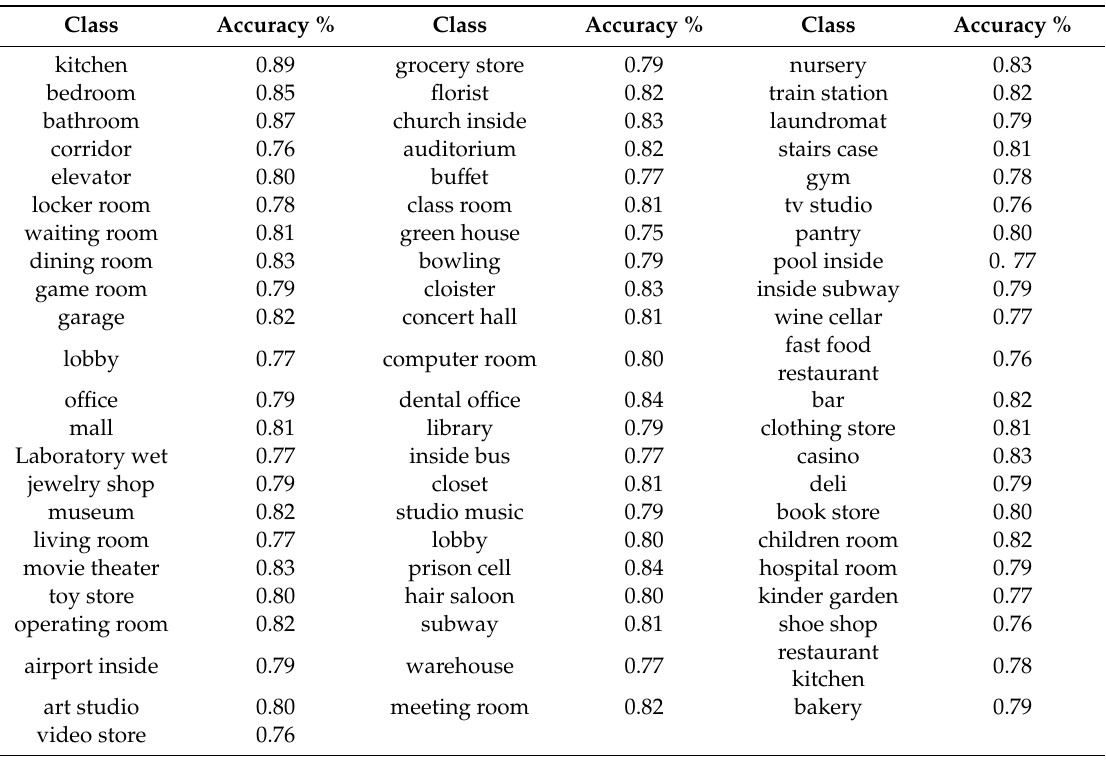
Table 8. Confusion Matrix of scene classification accuracy for the proposed approach using the CVPR 67 indoor scene